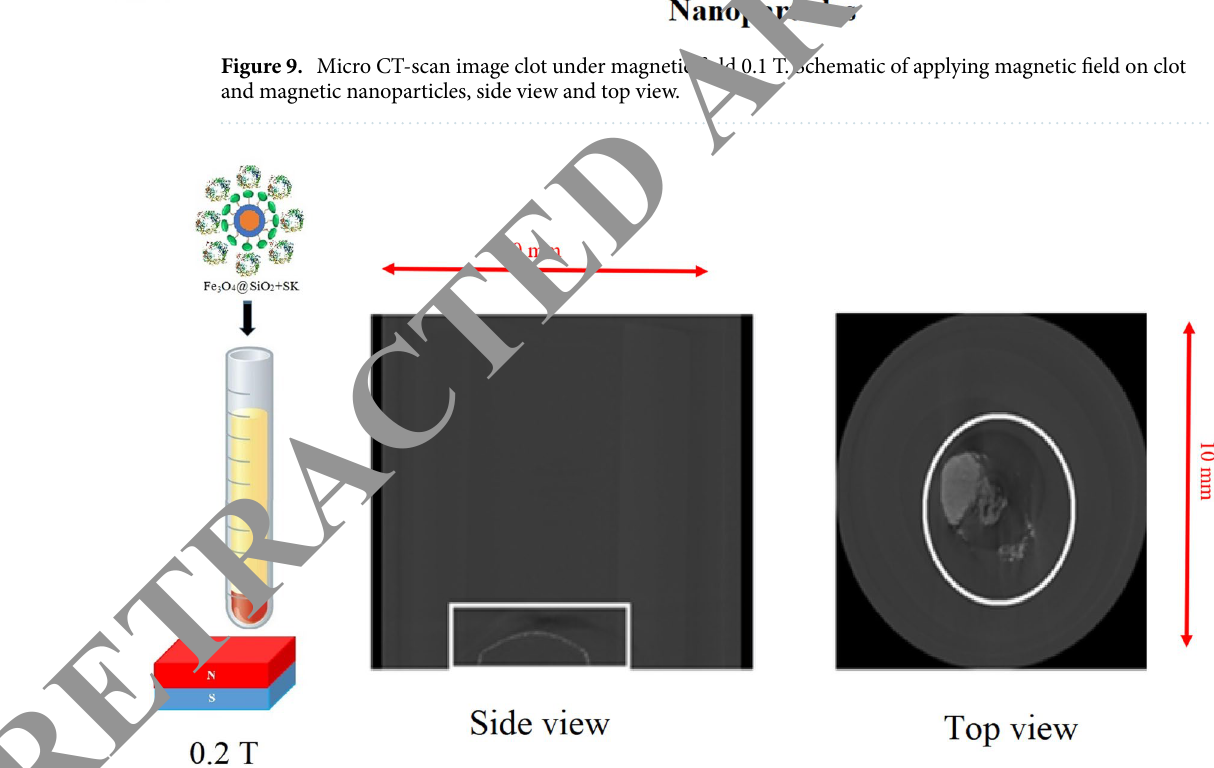
Figure 10. Micro CT-scan image clot under magnetic field 0.2 T. Schematic of applying magnetic field on clot and magnetic nanoparticles, side view and top